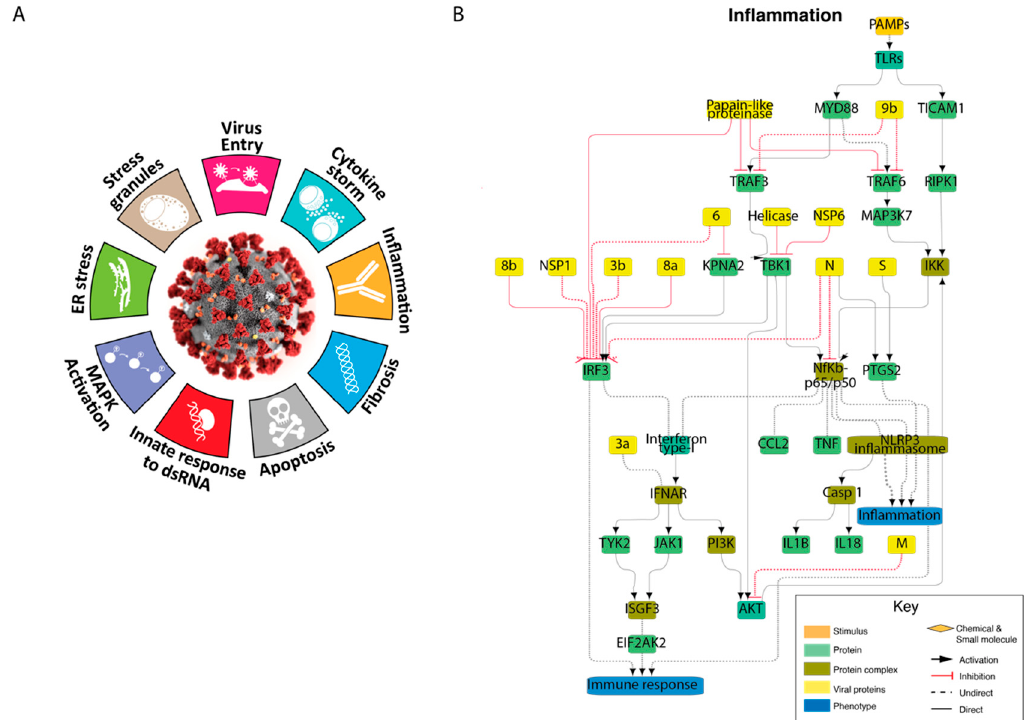
Figure 3. Graph representation of the SARS-CoV-2 hallmark phenotypes. ( A ) Graphical representation of coronavirus disease 2019 (COVID-19) hallmarks. ( B ) Causal network representing the modulation of the “inflammation” phenotype by viral infection; inflammation was chosen as an example. The remaining eight hallmark networks are shown in Figure S2 or can be inspected in the online resource (https://signor.uniroma2.it/covid/ (accessed on 25 February 2021)). Cellular and viral proteins are represented as green and yellow rectangles, respectively. Protein complexes are in a different tone of green whereas large blue rectangles label phenotypes. Chemicals targeting important nodes are represented as orange rhombi. Black and red arrows represent activations or inhibitions. Indirect relationships are drawn with dashed lines.